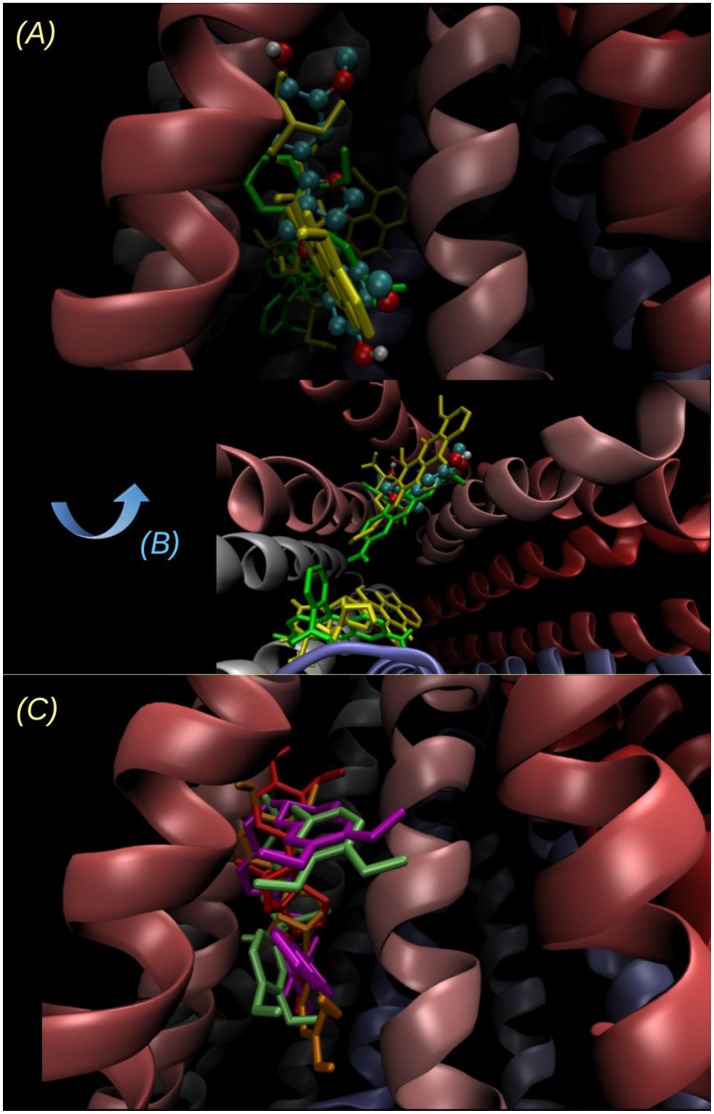
Two different views of the lowest energy docked structure of 14. (A) Point of view looking to the inverted “V” within the bilayer plane, the same point of view as in Figure 11 and (B) looking from the intracellular side to outside (perpendicular to the bilayer plane). The binding pose of 14 (ball and sticks) is compared to the main and secondary sites of Rhodamine 123 (yellow tubes) and DOX (green tubes). The sites of lowest energy are opposite for Rho 123 and DOX, and the energy difference between the secondary site and the main (reported on Table 2) is below 0.5 kcal/mol in both cases. (C) Superimposition of the lowest energy poses of 14 (orange), 16 (red), and the known inhibitors verapamil (lime) and tariquidar (violet).